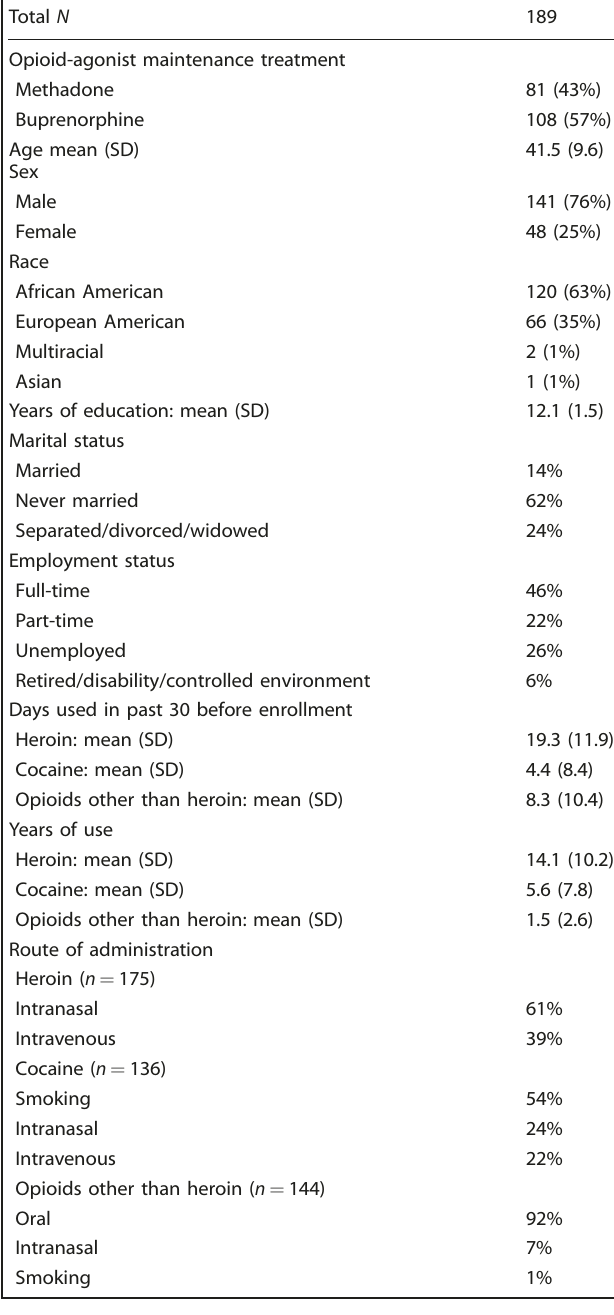
Table 1. Clinical and demographic